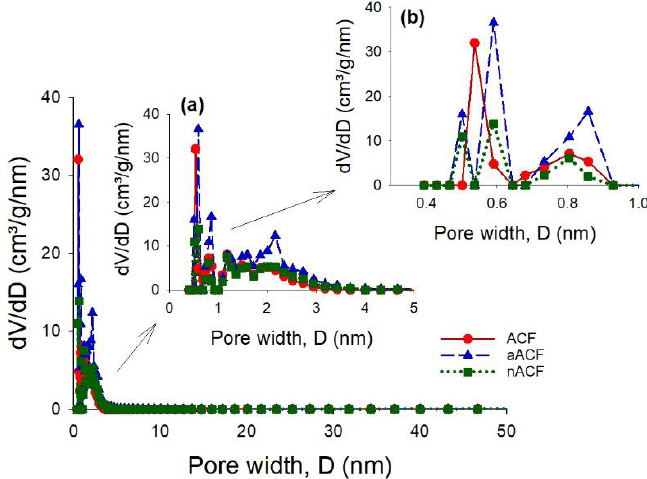
Figure 1. Pore size distributions of the activated carbon fiber samples obtained from the DFT method, where: inset ( a ) micropore range; inset ( b ) ultramicropore range.